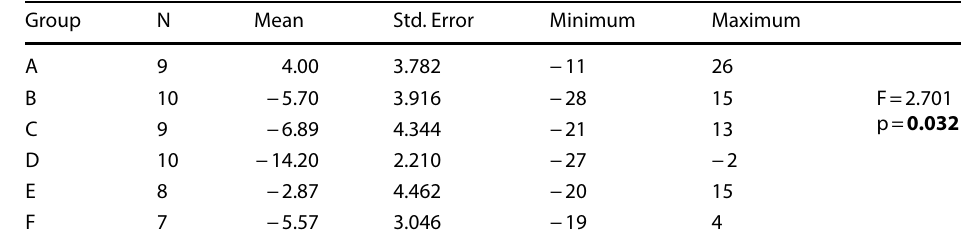
Fig. 2 Within Subject Effects: Estimated Marginal Means of FBS over time. *Standard deviations are represented as black dashes (–) on the black vertical lines connecting the coloured